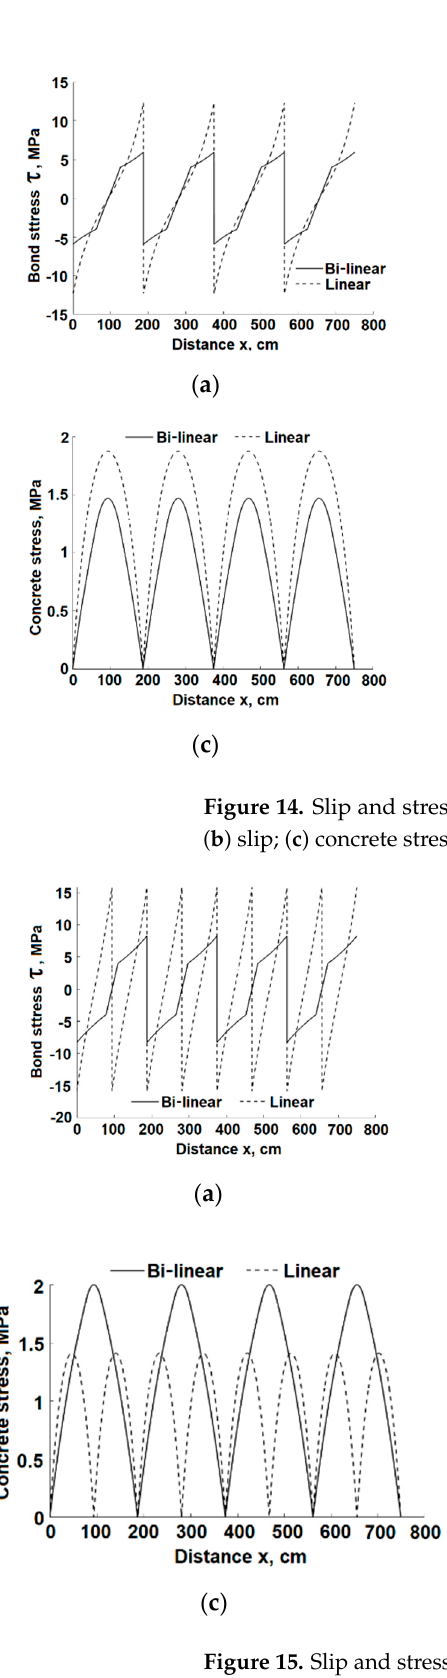
Figure 13. Slip and stresses distributions after second cracking stage ( P = 20.9 kN). ( a ) bond stress;